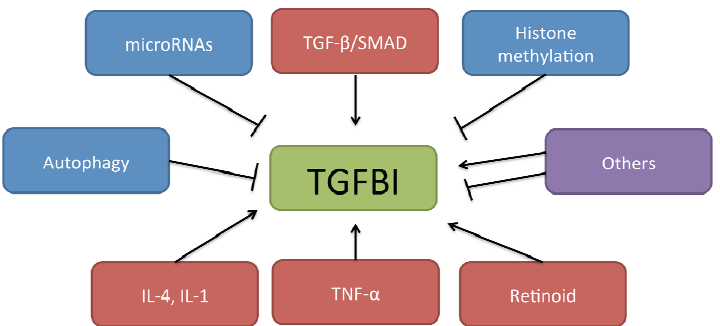
Figure 1. Mechanism of TGF- β -induced protein (TGFBI) regulation. TGFBI is regulated not only by TGF- β /SMAD signaling but also by other mechanisms including microRNAs, histone methylation, autophagy, interleukins, tumor necrosis factor- α , and retinoid.